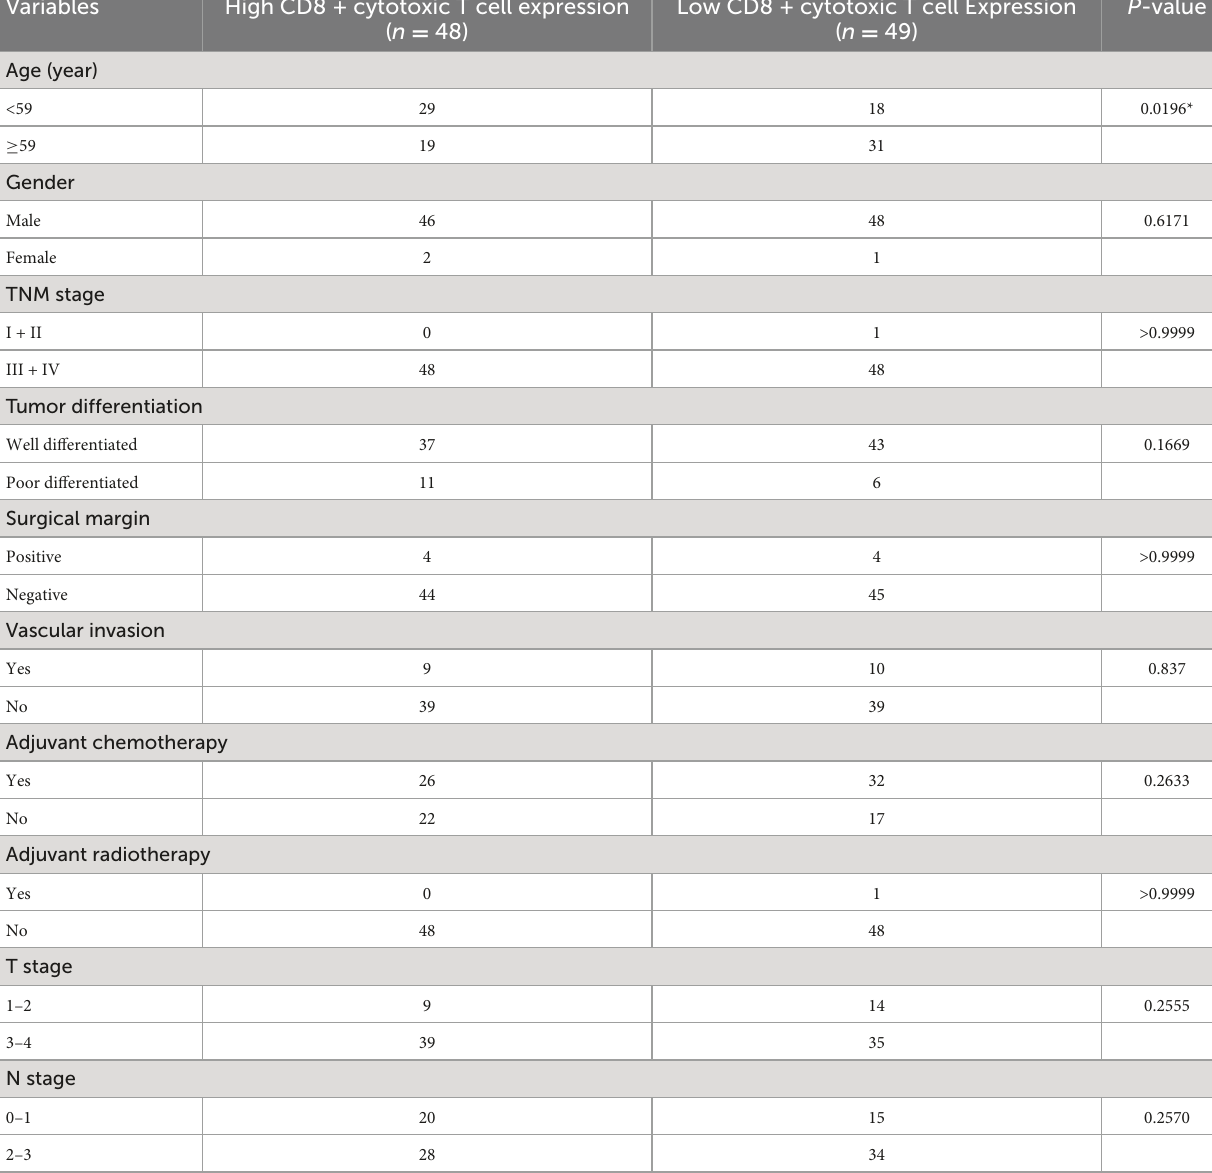
TABLE 4 The relationship between intratumoral CD8 + cytotoxic T cell infiltration and clinical characteristics. Variables High CD8 + cytotoxic T cell expression ( n =